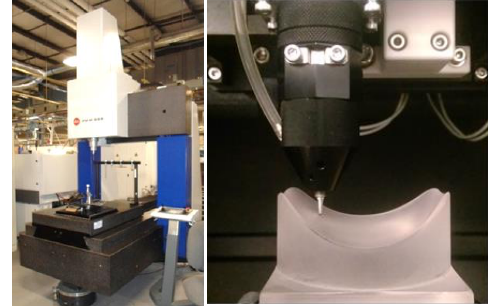
Figure 3 . CMM and UA3P at Optimax.